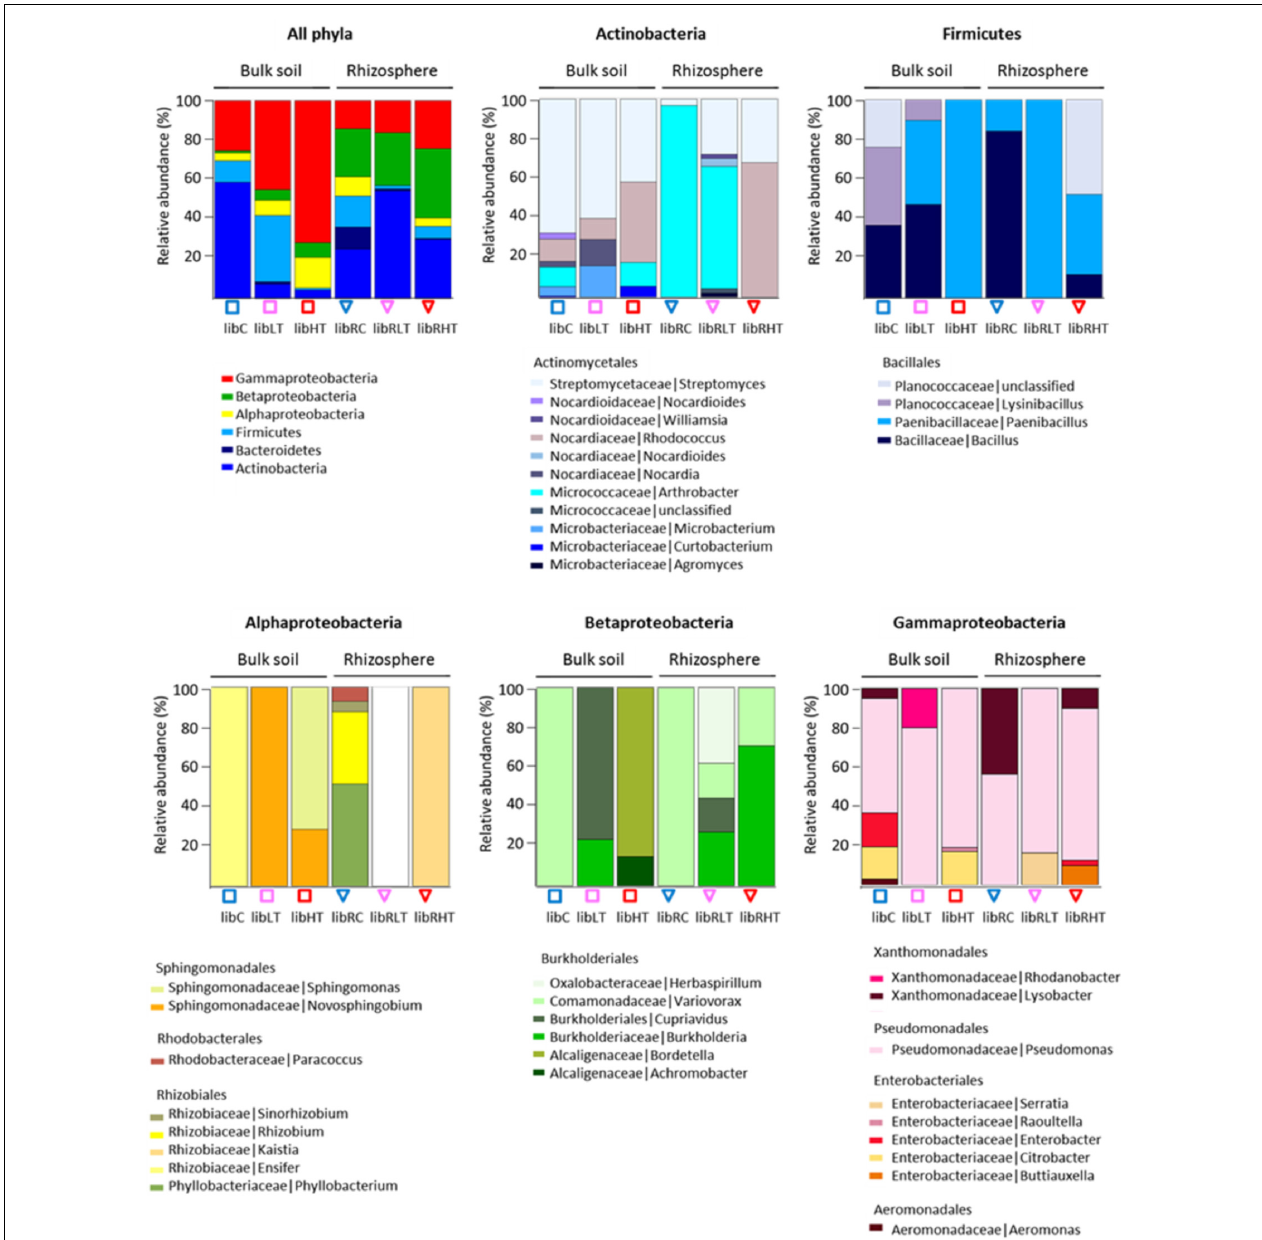
FIGURE 2 | Overview of the genotypic identification and distribution of the isolated CFUs. Phyla and Proteobacteria class level are shown and the distribution of families present among the Actinobacteria, Firmicutes, Alphaproteobacteria, Betaproteobacteria, and Gammaproteobacteria.